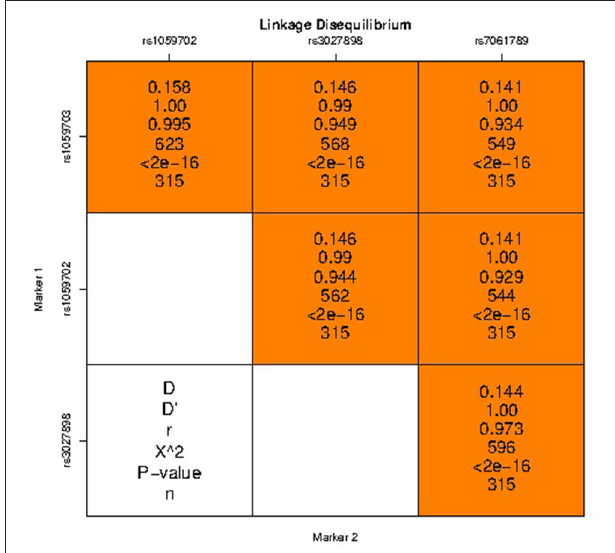
FIGURE 1 | Linkage disequilibrium diagram of four SNP loci in the IRAK1 gene.